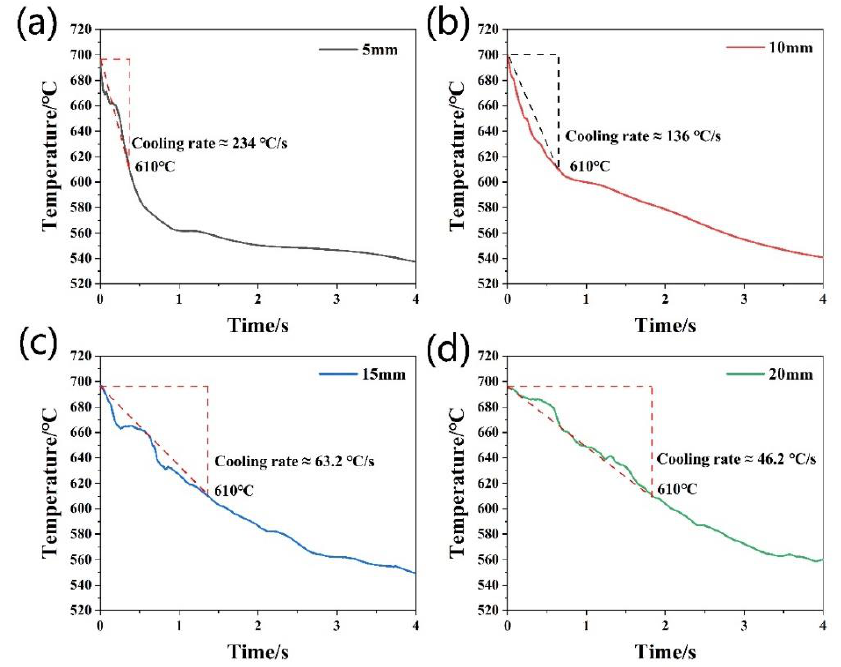
Figure 1. Cooling curves and the measurement approach of cooling rates during solidification of four different thickness of samples: ( a ) 5 mm, ( b ) 10 mm, ( c ) 15 mm, and ( d ) 20